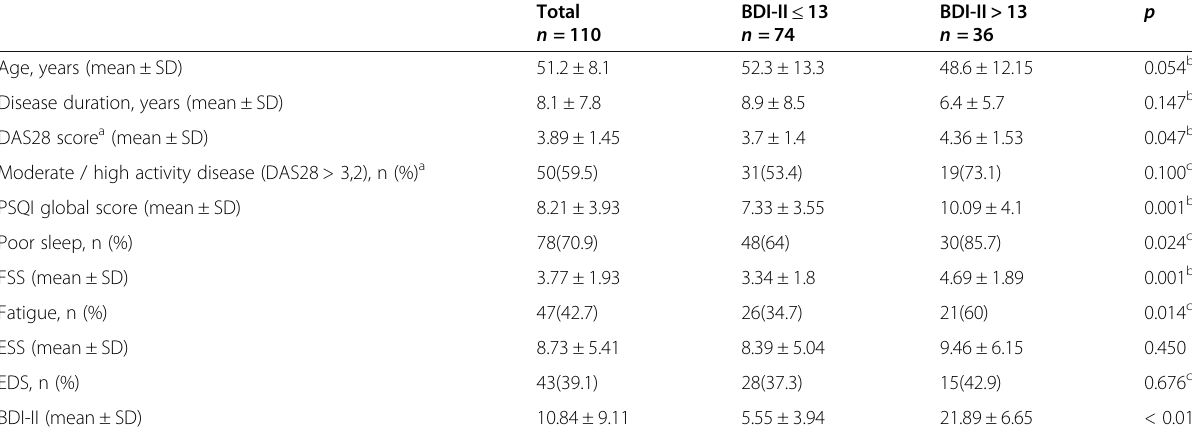
Table 1 Demographic and clinical characteristics, quality of sleep, fatigue, and daytime sleepiness in 110 RA female